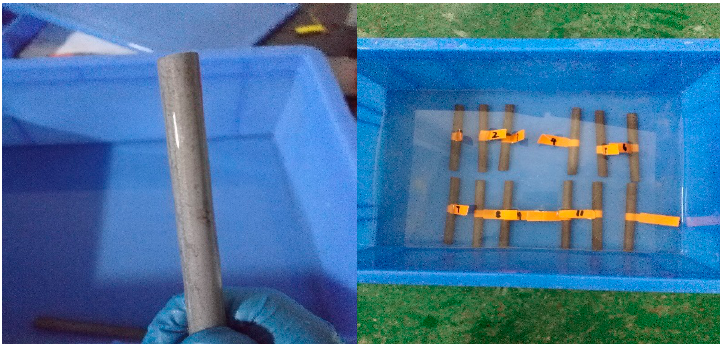
Figure 3. Test process of weight-loss method.